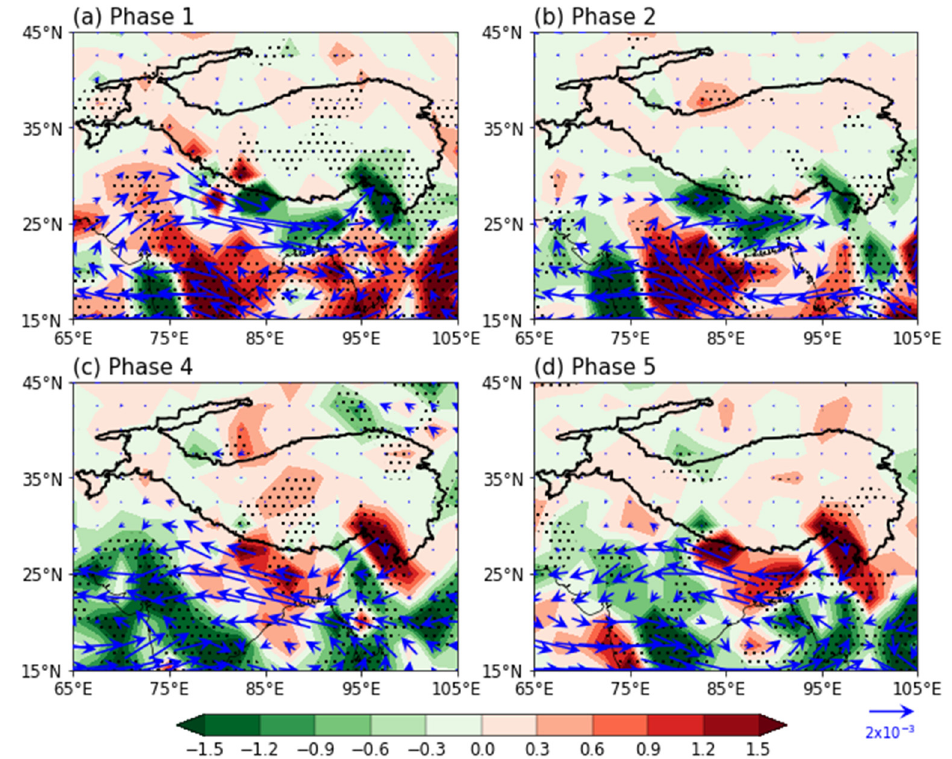
Figure 10. Composite patterns of the 850 hPa anomalous horizontal moisture fluxes (vectors; kg m − 1 s − 2 ) and their divergence (shading; 10 − 9 kg m − 2 s − 2 ) in MJO Phases ( a , b ) 1 ‒ 2 and ( c , d ) 4 ‒ 5. The dots indicate that values are statistically significant at the 95% confidence level. The thick black curves show the Tibetan Plateau.